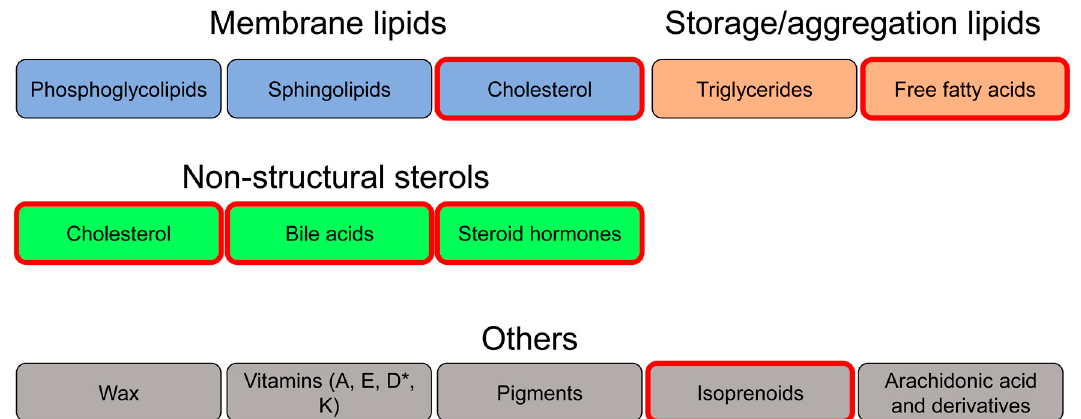
Figure 2. Types of lipids that are suggested to be regulated by SUMOylation: Collection and classification of lipids based on textbook literature [19]. The red frames label lipids that are suggested to be regulated by SUMOylation. These include, for example, ergosterol in yeasts [24–26]; isoprenoids in C. elegans [27]; and, in mammals, cholesterol [28], bile acids [29,30], and free fatty acids [31,32]. Lipids are grouped by their biological functions and not by their chemical properties. Cholesterol has both structural and nonstructural roles; thus, it appears in two different categories. * Vitamin D is a byproduct of cholesterol, but it is grouped with other vitamins based on its biological function.